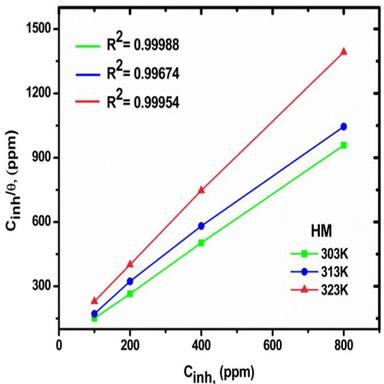
Langmuir isotherm for the adsorption of HM in 1 M H2SO4 at different temperature.